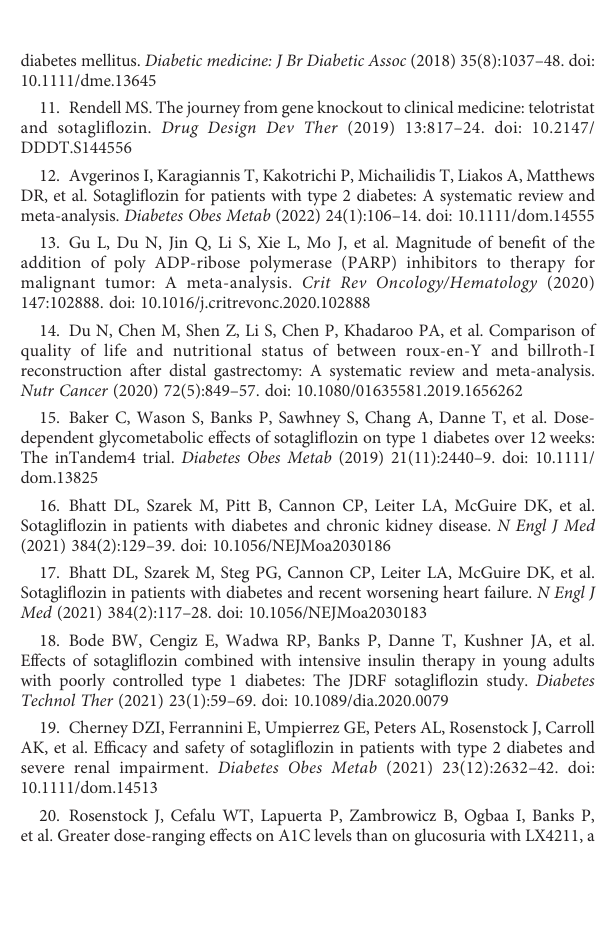
SUPPLEMENTARY FIGURE 3 Sensitivity analysis of the secondary clinical outcomes for KMC versus the control